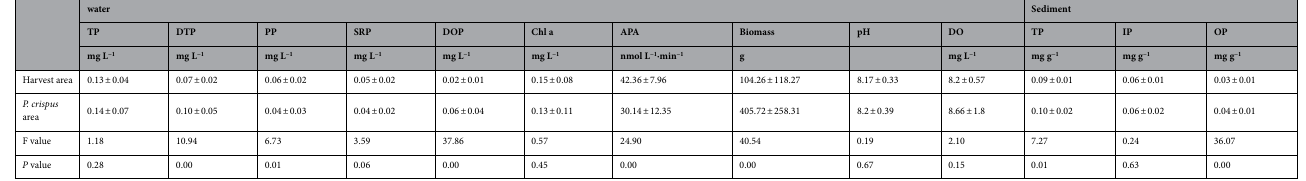
Table 1. Tukey’s post hoc analysis of the two-way ANOVA test between Harvest area and P. crispus area of water and sediment chemical and physical parameters (means ±